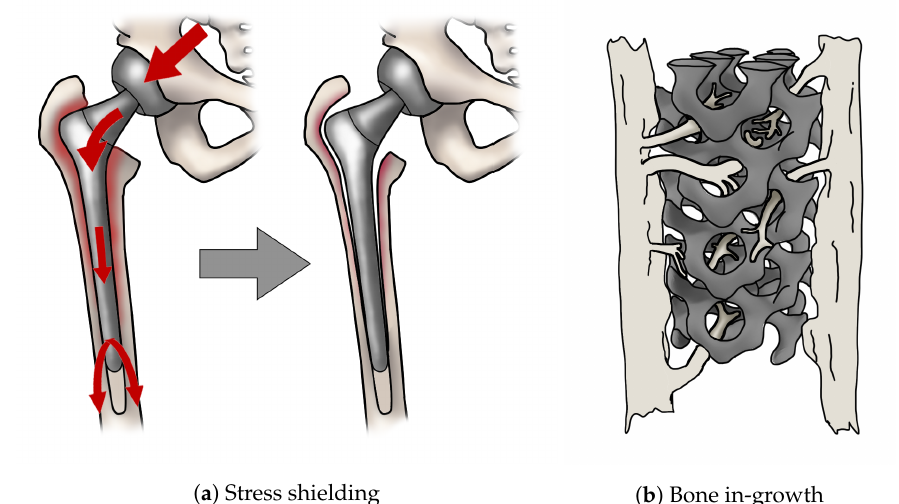
Figure 2. Schematic representation of ( a ) new loading conditions in solid hip implants, and ( b ) bone in-growth of porous